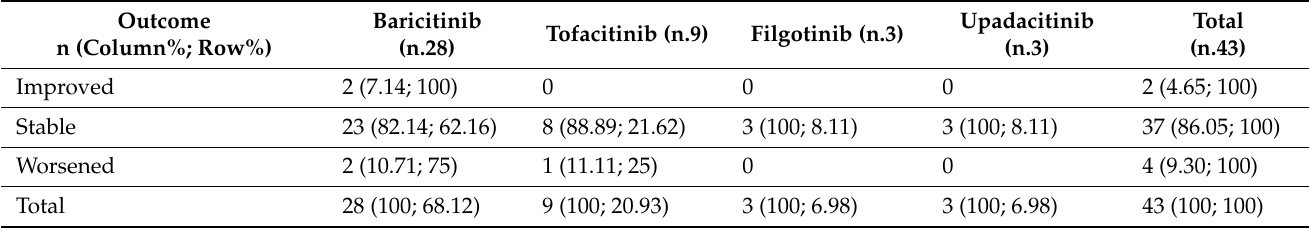
Table 2. HRCT evolution in different JAKi